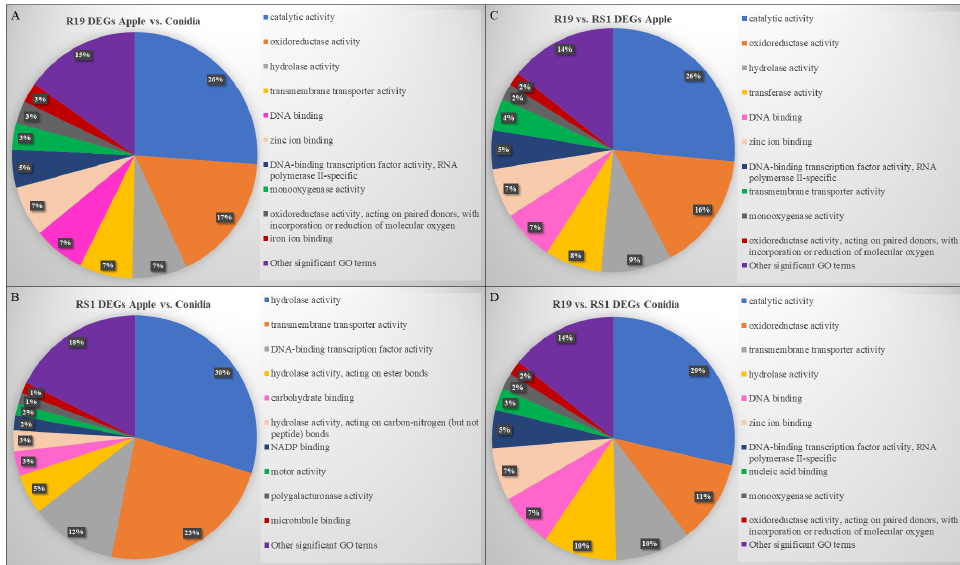
Figure 5. Top 10 molecular functions of differentially expressed genes (DEGs) in Penicillium spp. R19 and RS1 from ramifying hyphae and mycelium in apple and ungerminated conidia. Gene ontology analysis of ( A ) R19 ‐ decayed apple and ungerminated conidia DEGs, ( B ) RS1 ‐ decayed apple and ungerminated conidia, ( C ) R19 ‐ and RS1 ‐ decayed apple, and ( D ) R19 and RS1 ungerminated conidial transcripts. Gene ontology categories within the molecular functions subcategory are shown with the highest 10 categories for DEGs listed from each comparison. Gene ontology statistics performed using Fisher’s exact test and the weight01 algorithm ( p ‐ value < 0.01).